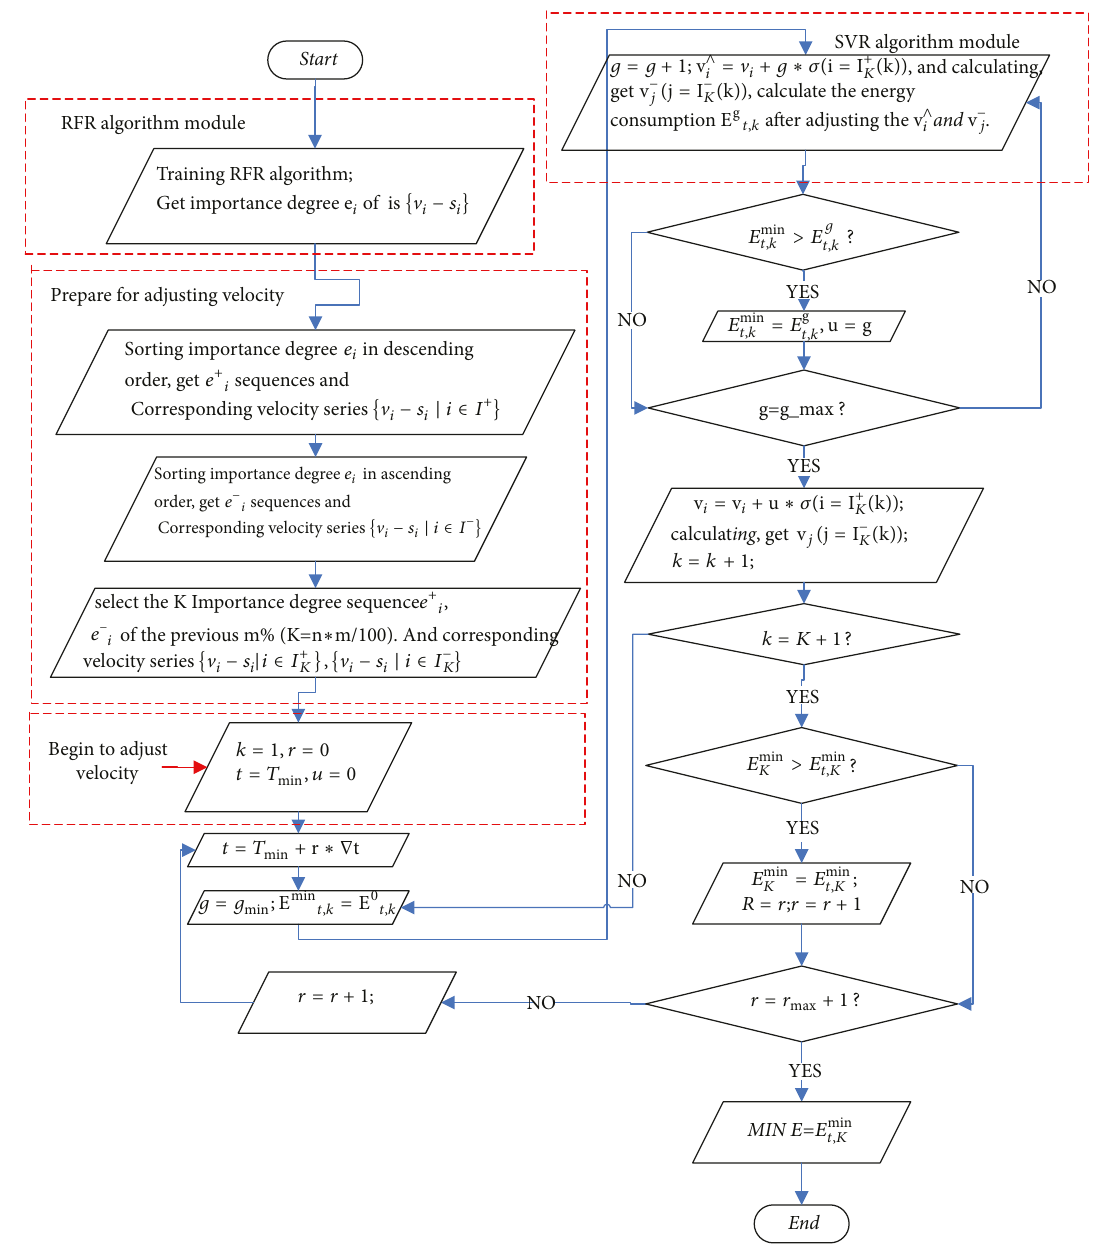
Figure 13: Algorithm